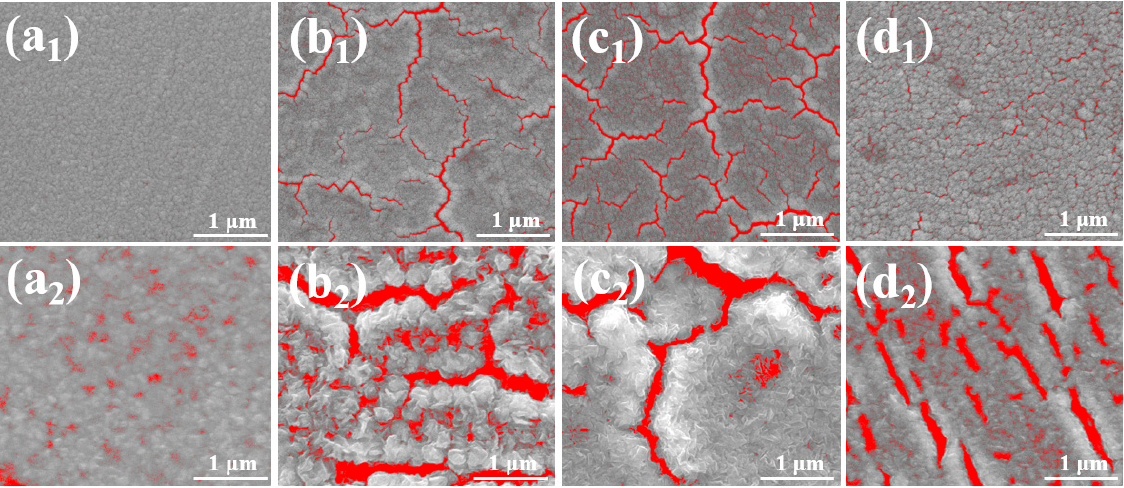
Figure 7. SEM images of films processed by Image J: ( a 1 – d 1 ) 0.4 Pa, 0.6 Pa, 0.8 Pa and 1.0 Pa before